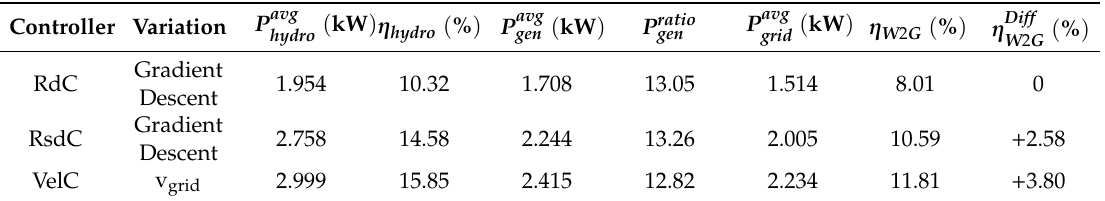
Table 9. Summarized results from the 1500 s random wave simulation for RdC, RsdC and VelC. Controller